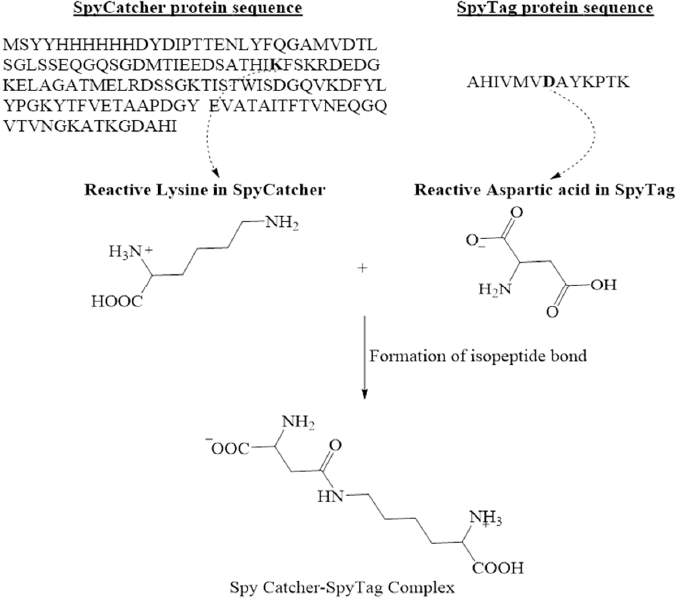
Figure 12. A peptide ‐ small protein ‐ based crosslinker, SpyTag ‐ SpyCatcher, forms an isopeptide bond by the reaction of the 117th residue (aspartic acid ‐ D) of SpyTag and 31st residue (lysine ‐ K) of SpyCatcher (GenBank: AFD50637.1).